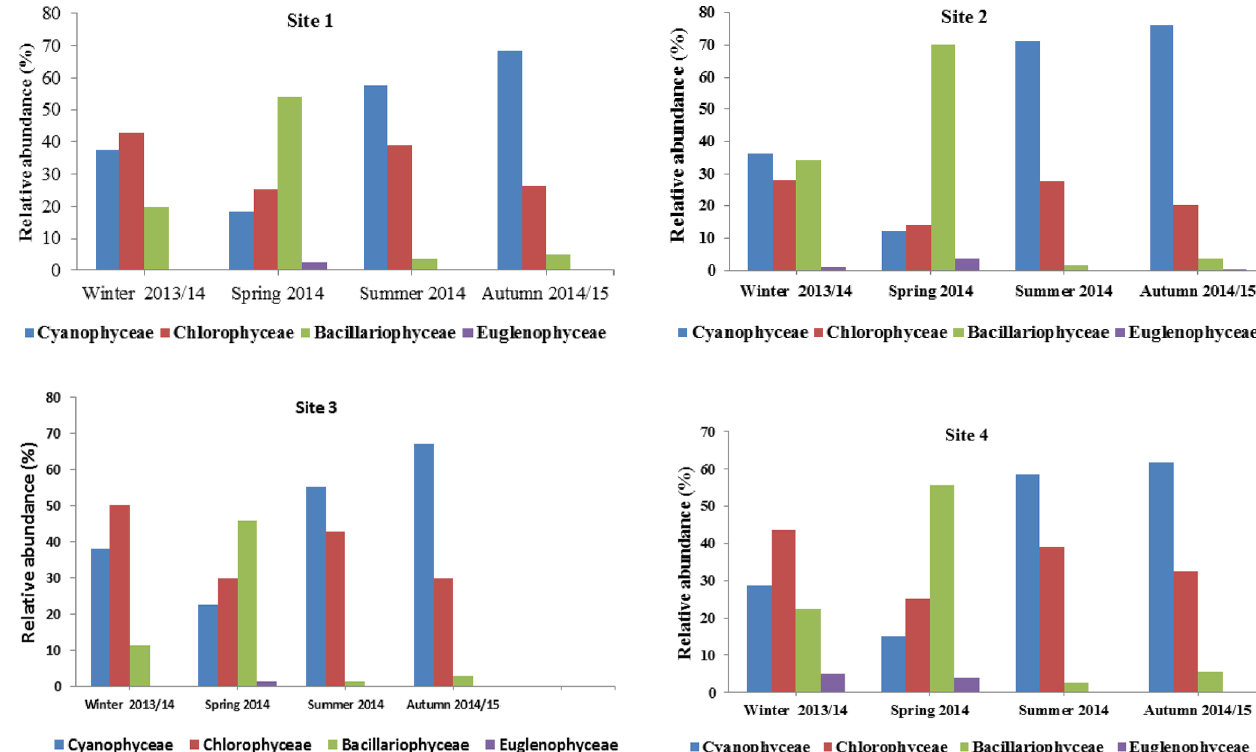
Fig. 2. Seasonal relative abundance of phytoplankton in Lake Chamo